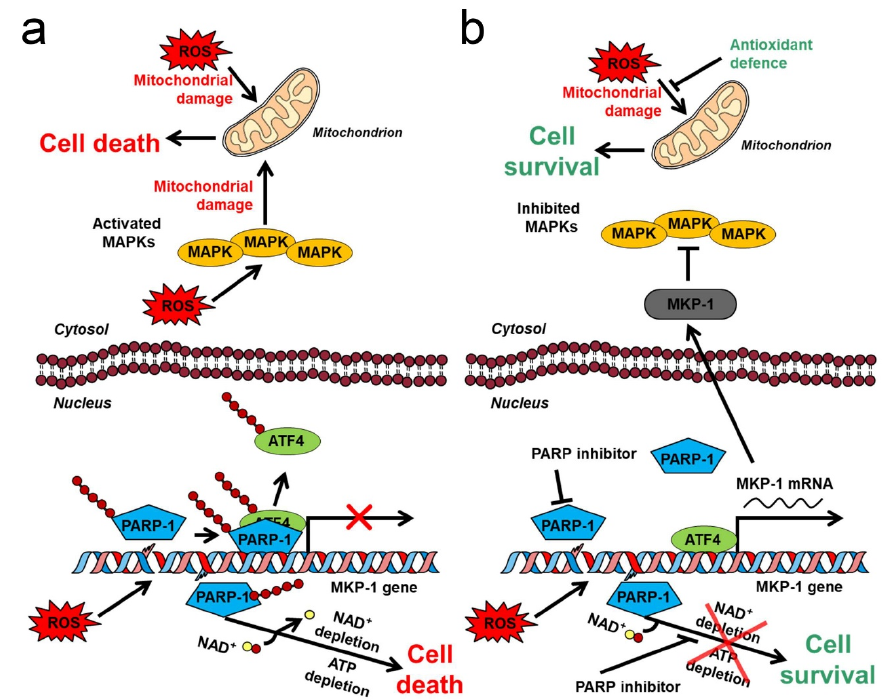
Figure 2. Interplay of PARP with MAPK-mediated mitochondrial damage in oxidative stress. ( a ) E ff ects of oxidative stress in the absence of PARP inhibition. ROS-induced DNA strand breaks